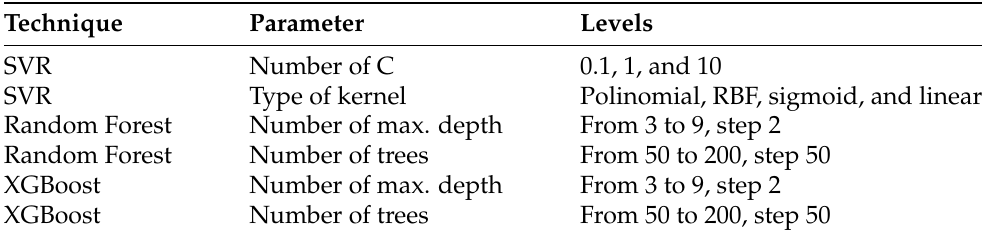
Table 2. Machine learning parameters and